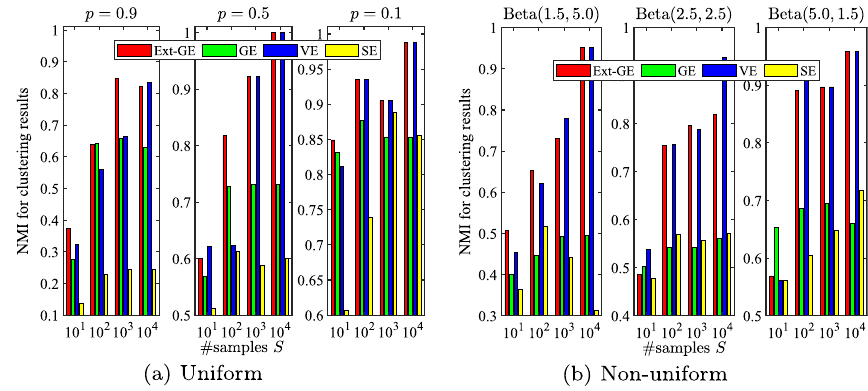
Fig. 10 NMI of clustering results ¯ H against those by true similarity matrix